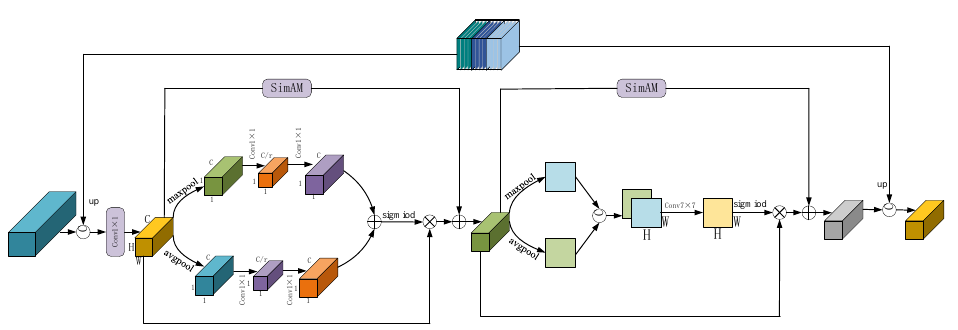
Figure 5. Multi-scale convolution attention module.